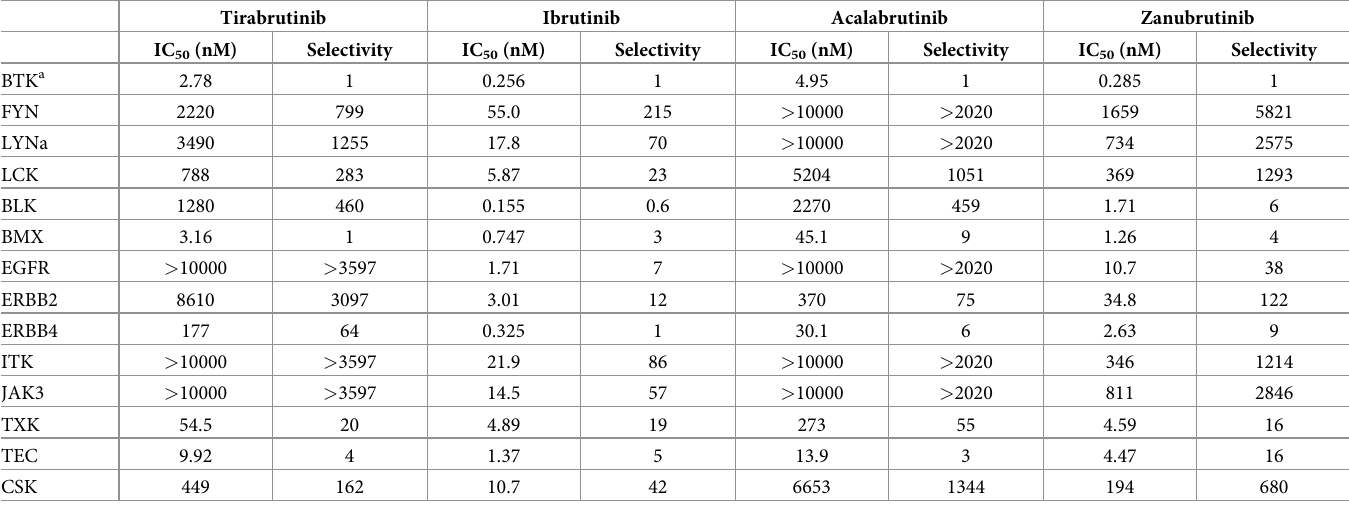
Table 1. Selectivity of first-and second-generation BTK inhibitors against 13 kinases.